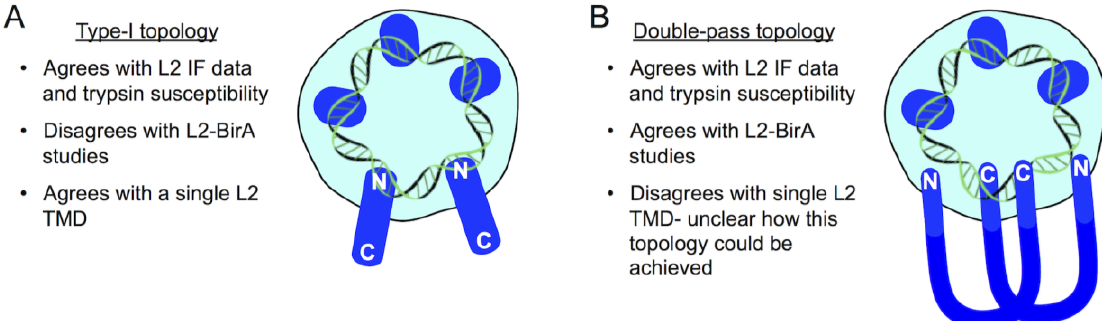
Figure 4. Topology models of L2 protrusion. Both models are consistent with published L2 immunofluorescence and trypsin susceptibility data [80]. ( A ) In the type-I model, the N-terminus remains lumenal with all ~400 residues downstream of the TMD being cytosolic to recruit sorting factors. L2-BirA would be expected to biotinylate substrate in this model, contradicting the actual data [51]. ( B ) In the double-pass model, both the N- and C-termini would be lumenal, with the bulk of L2 being cytosolic. L2-BirA would not be expected to biotinylate substrate as observed. However, the means by which L2 spans the membrane a second time is difficult to conceptualize, as the protein only has one TMD towards the N-terminus [79]. In vitro data suggest both the N- and C-termini are capable of non-speciific dsDNA binding through electrostatic interactions [12,14].